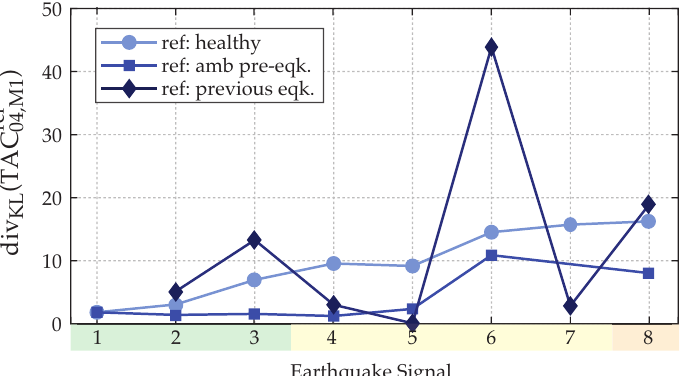
Figure 18. Evolution of the damage identified with the TAC using the KL divergence and changing reference distributions derived from: WN excitation in the healthy reference state, WN in the pre- earthquake state, and GM signal of the previous